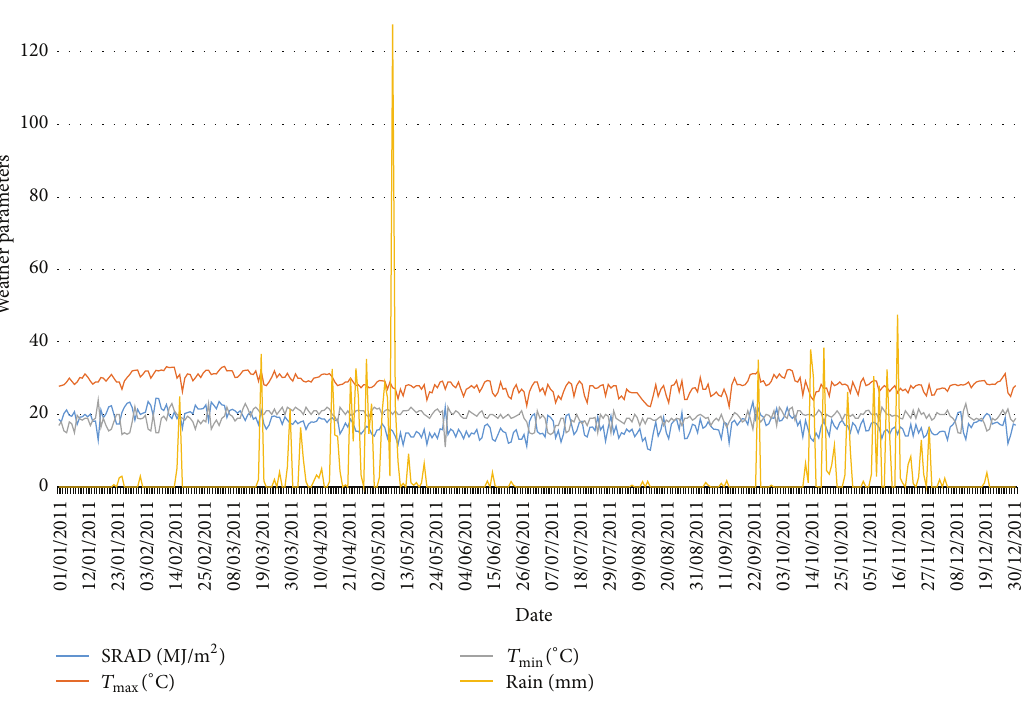
Figure 1: Mwea weather for